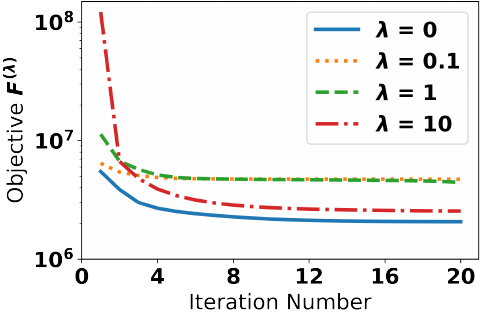
Figure 1. Illustration of decreasing objective function at r = 3 topics for λ ∈ { 0 } ∪ { 10 i /2 | i ∈ Z ∩ [ − 2,2 ]